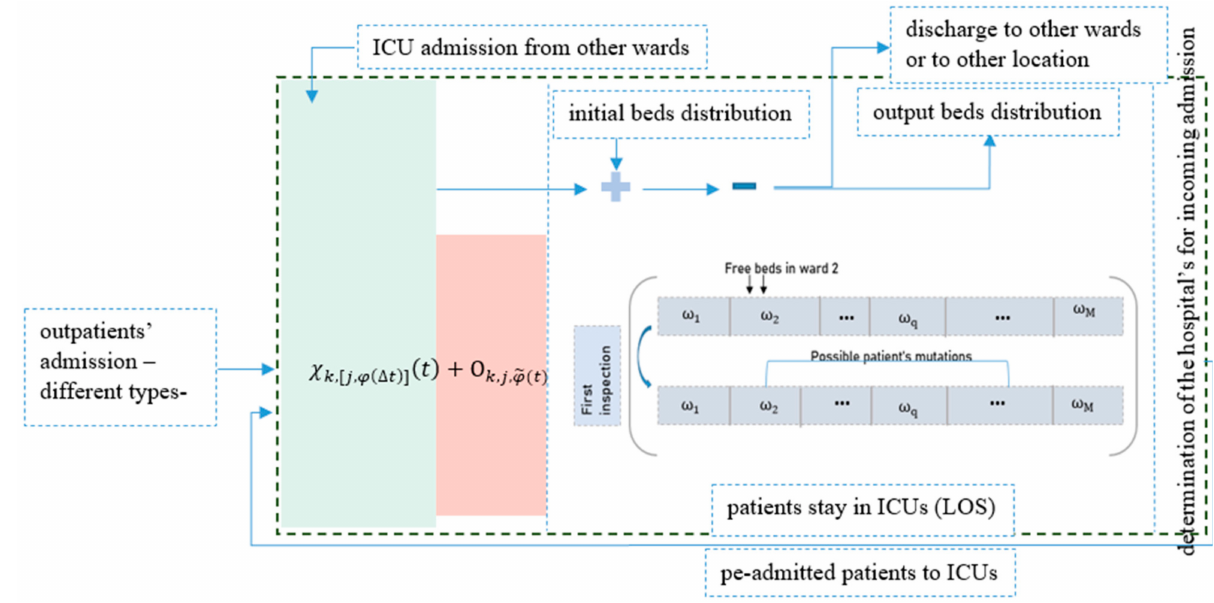
Figure 1. Flow dynamic in